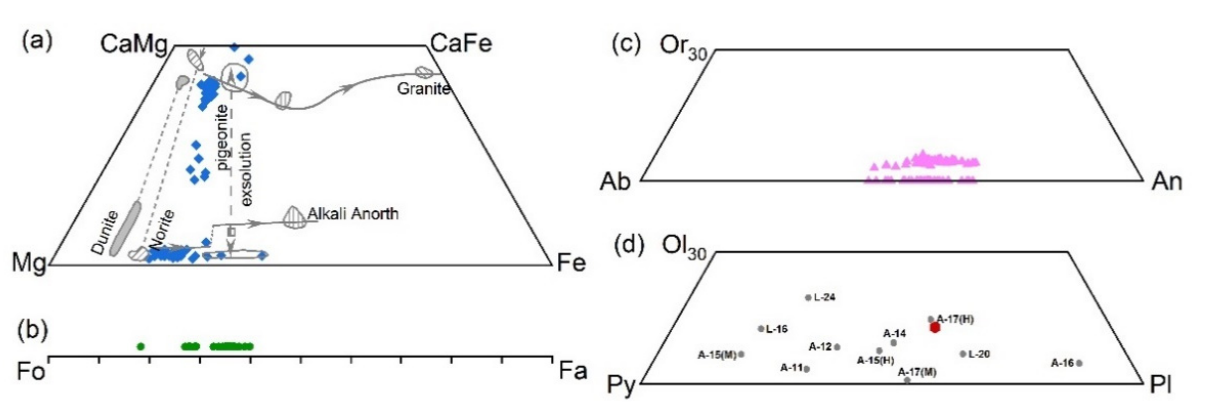
Figure 4. ( a ) Composition of pyroxene in the Ca-Mg-Fe quadrilateral [24]. ( b ) Range of compositional variation in olivine. ( c ) Composition of feldspars in the Or (30%)-Ab-An triangle. ( d ) Composition of CR-1 in the olivine (30%)-pyroxene-plagioclase triangle [24]. The results of this study are marked as color points.